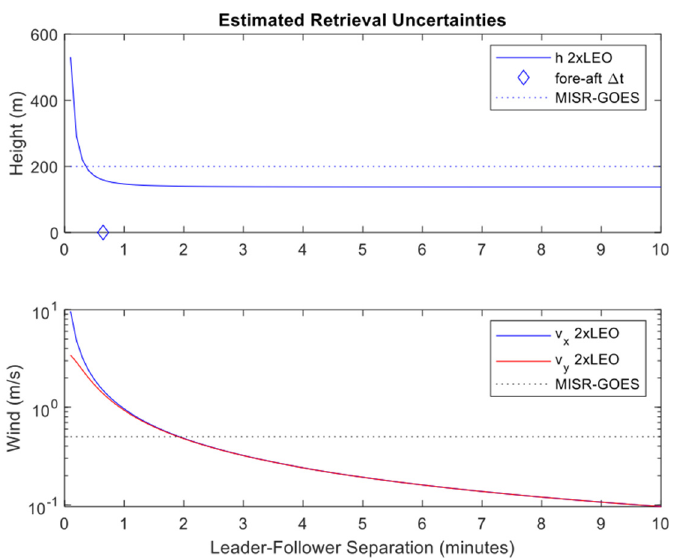
Figure 22. Leader–follower retrieval uncertainties as a function of separation between the satellites. The simplified model includes only random errors. The practical accuracies achieved using the MISR A cameras and GOES are shown as dashed lines independent of the time separation between MISR and GOES acquisitions [4]. In practice, the contributing errors are more nuanced and include, for example, the effect of cloud shape changes that grow with T . Good results with operational satellites winds are achieved with T = 1, 5, and 10 min that are characteristic of GOES-R MESO, CONUS, and Full Disk repetition rates. As T grows to 15 min and beyond, cloud shape changes begin to affect matching accuracy and diminish the number of high-quality matches.